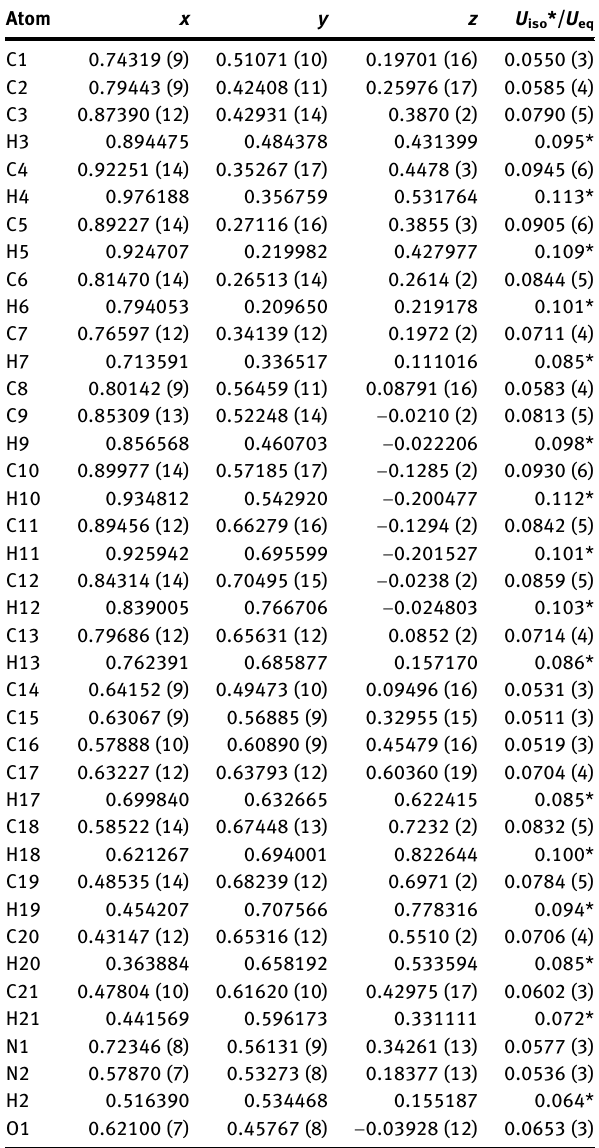
Table  : Fractional atomic coordinates and isotropic or equivalent isotropic displacement parameters (Å 